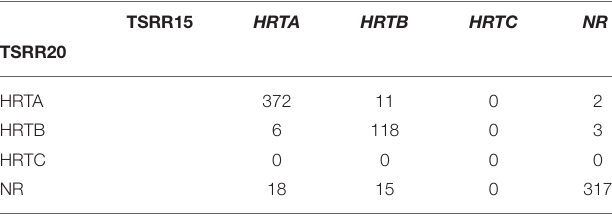
TABLE 3 | HRTA-C classes of files before and after changing #TSRR from 15 (columns) to 20 (rows) during HRT